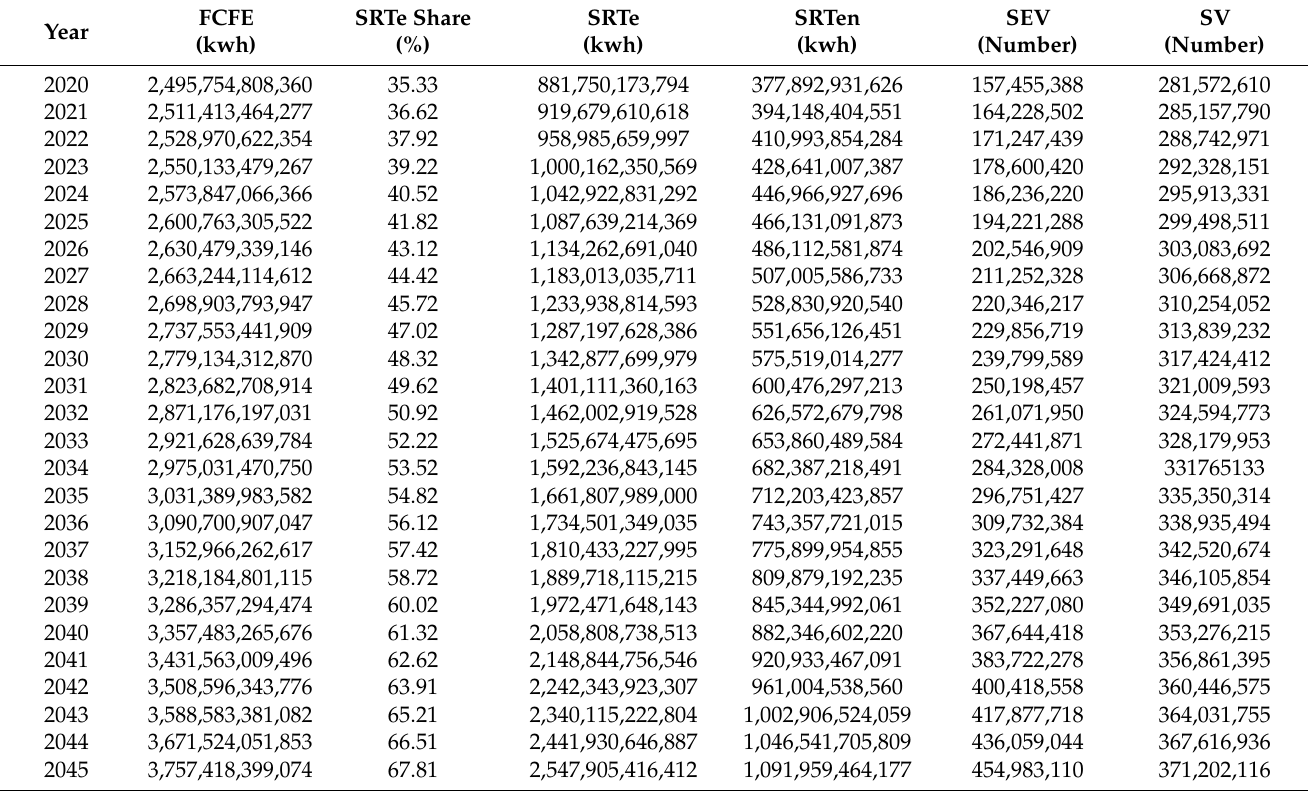
Table A2. Forecasts for data series selected using